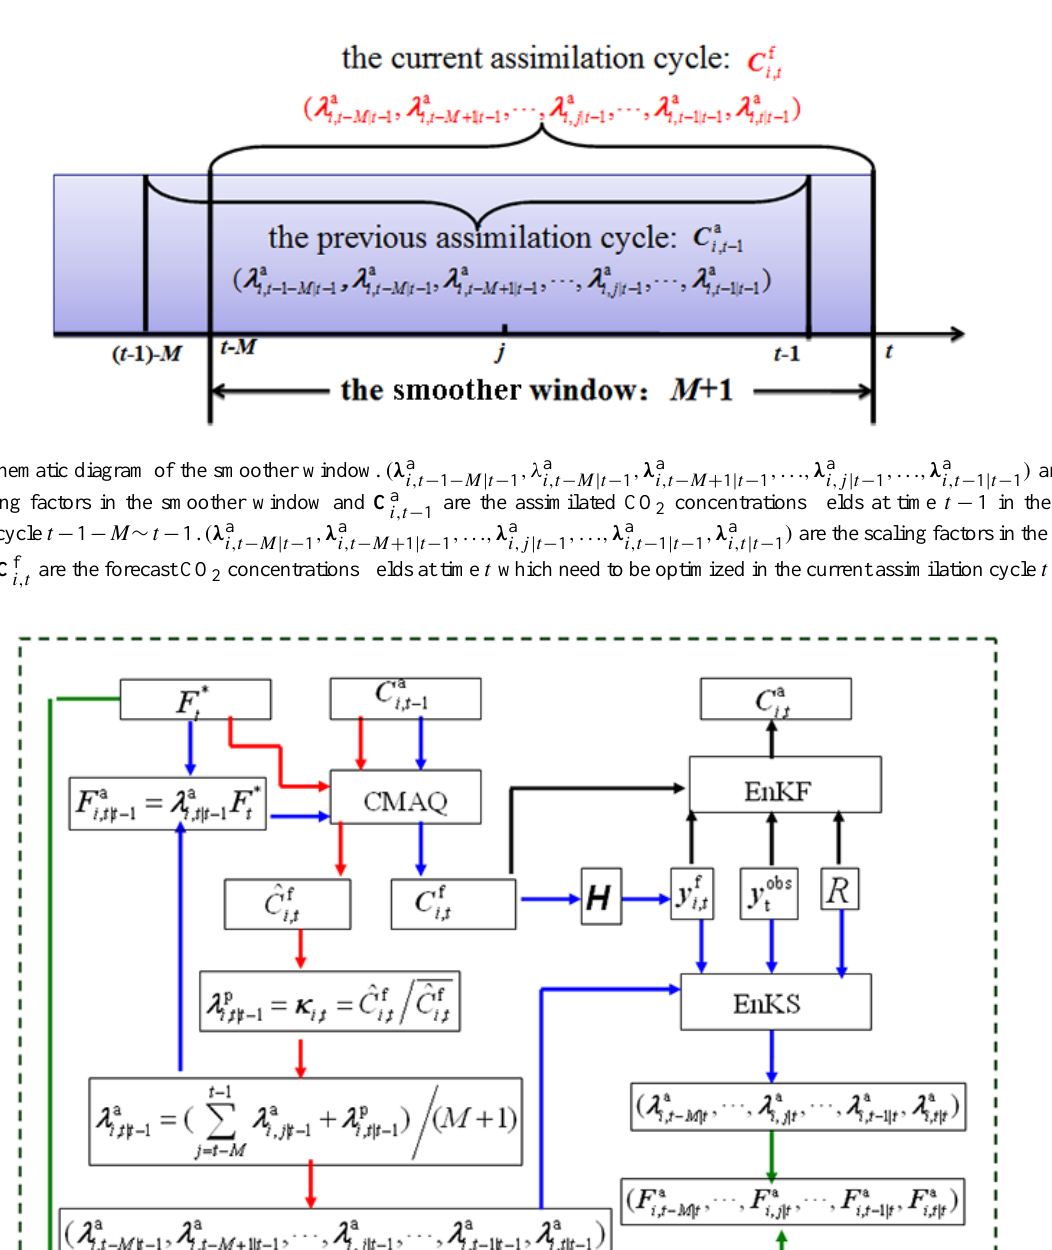
Figure 2. Flowchart of the CFI-CMAQ system used to optimize surface CO 2 fluxes at each assimilation cycle. The system includes the following four parts in turn: (1) forecasting of the linear scaling factors λ a (red arrows); (2) optimization of the scaling factors in the i,t | t − 1 smoother window by EnKS (see Fig. 1) (blue arrows); (3) updating of the flux in the smoother window (green arrows); and (4) assimilation of the CO 2 concentration fields at time t by EnKF (black